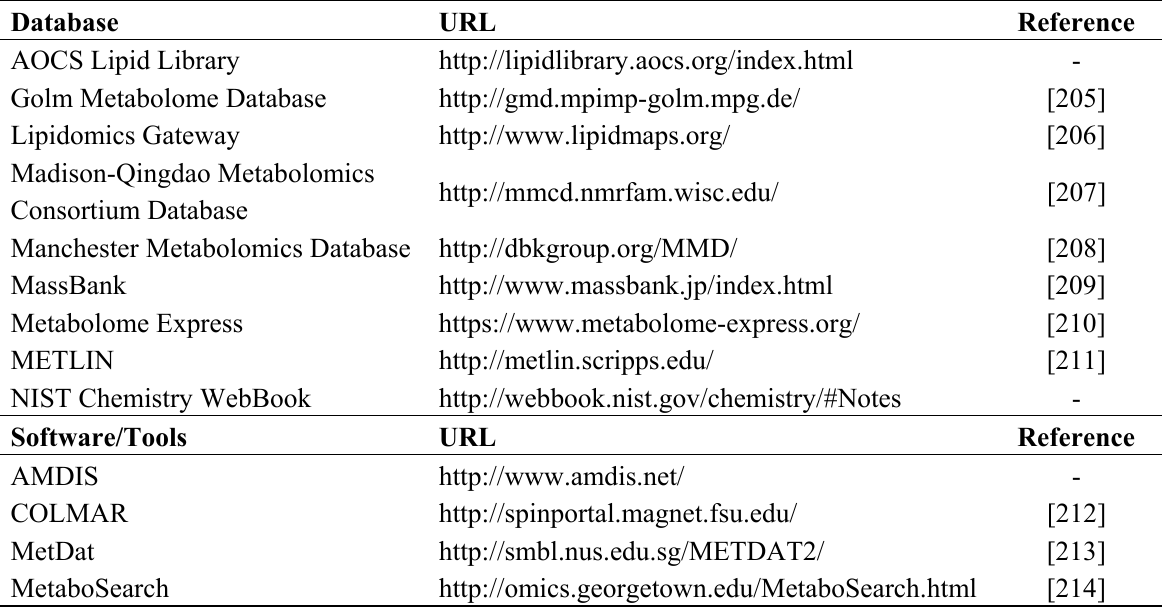
Table 9. Mass spectra databases and other bioinformatics resources for metabolomic